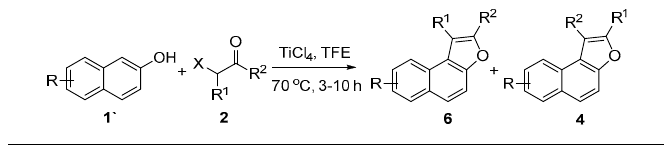
Table 2. Reaction of naphthols with different acyclic α -haloketones a, b, c .